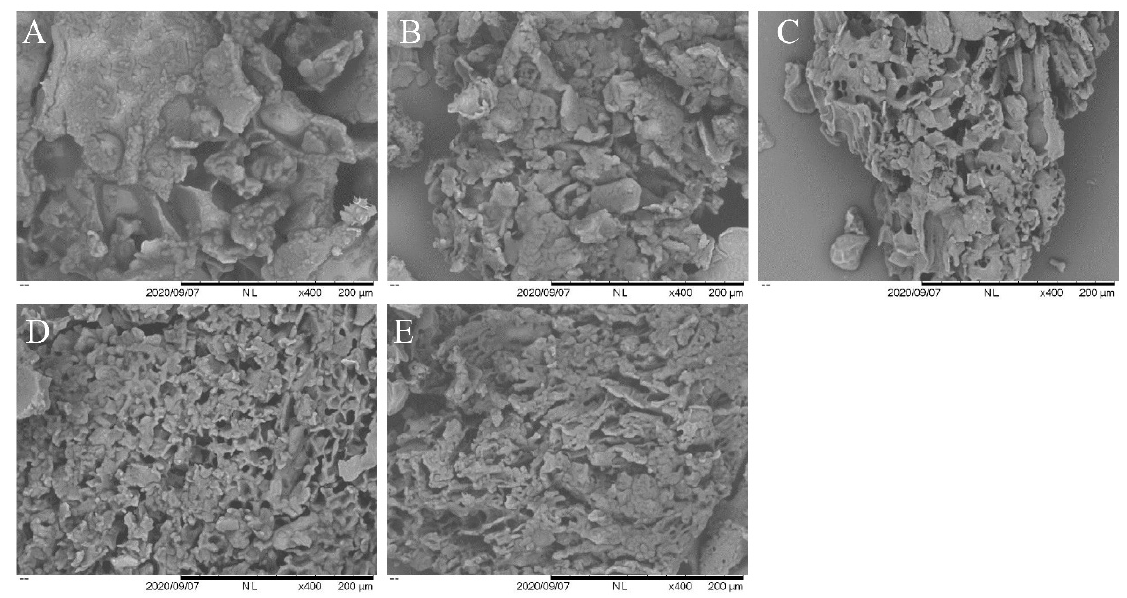
Figure 6. The effect of different ozone treatment time on the microstructure of chicken egg yolk powder. ( A ) 0 min; ( B ) 10 min; ( C ) 20 min; ( D ) 30 min; ( E ) 40 min.